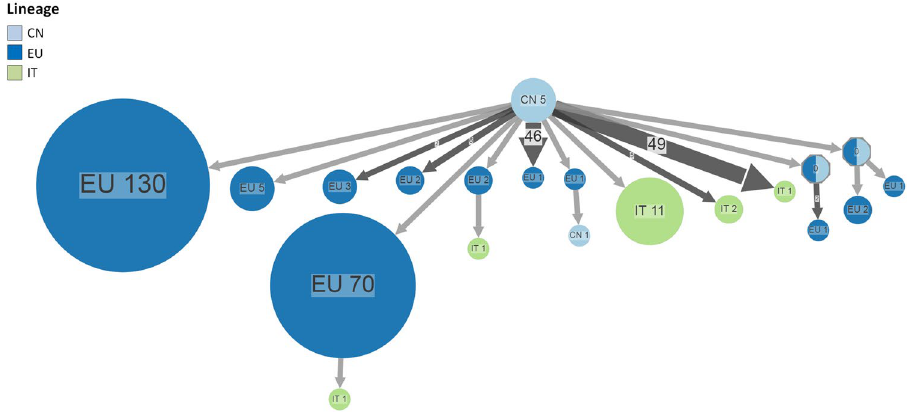
Figure 5. Ancestral reconstruction of SARS-CoV-2 lineages B using the European dataset. The figure shows the compressed visualization produced by PastML using marginal posterior probability approximation (MPPA) with an F81-like model. Different colours correspond to different European countries and lineages. Numbers inside (or next to) the circles indicate the number of strains assigned to the specific node. The joint ancestral scenario (Joint) and maximum a posteriori (MAP) predictions are shown for the uncertain nodes (shown as octagonal icons). CN, China; IT, Italy, EU,